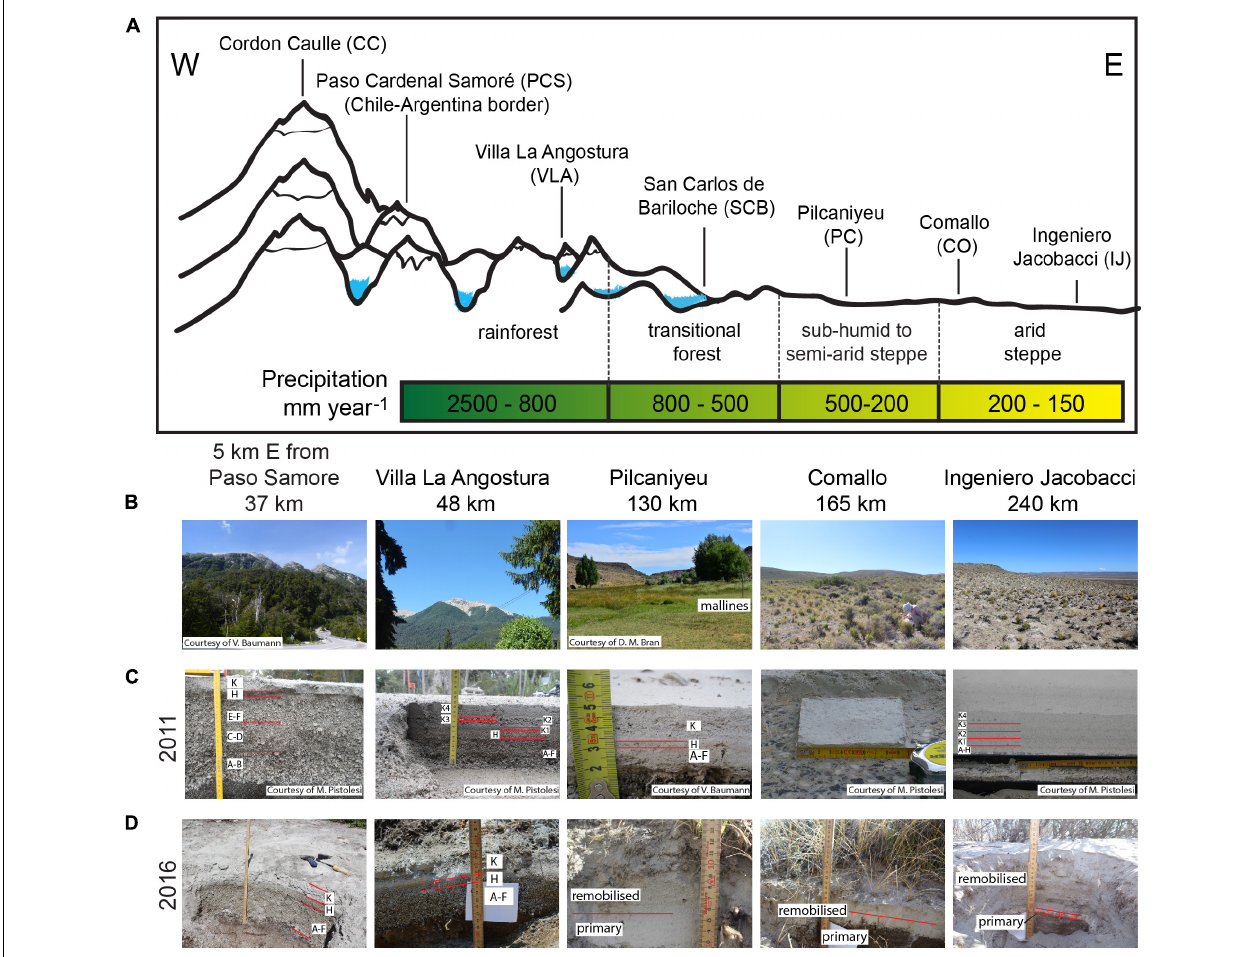
FIGURE 3 | (A) Schematised W-E transect showing the climatic gradient associated with precipitations and vegetation typology from the Andes range to the Patagonian steppe. Profile is indicative and not to scale. (B) Selected localities from proximal and distal areas showing the vegetation evolution along the transect (distances to the CC vent are indicated). (C,D) Primary tephra-fallout deposit at each location in 2011 and 2016,